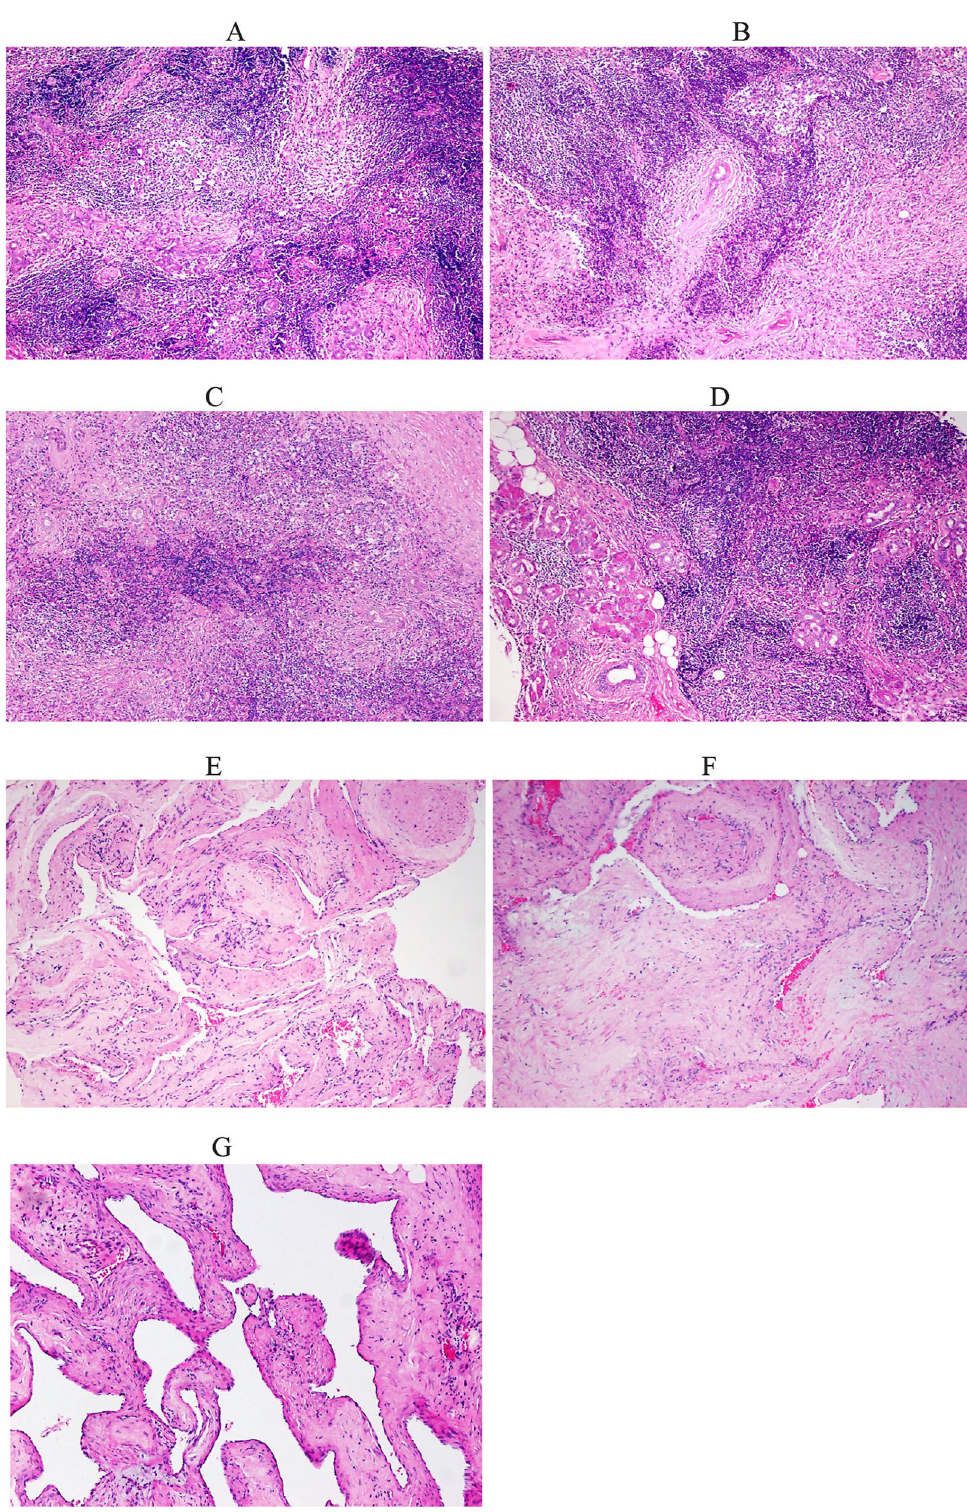
Figure 1. Pathological manifestations of benign lymphoepithelial lesions of lacrimal gland and cavernous hemangioma. ( A – D ) Diffuse infiltration of lymphocytes and plasma cells, atrophy and disappearance of glands, and hyperplasia of fibrous tissue. ( E – G ) The blood filled spaces are relatively uniform in size and are separated by fibrous tissue. (Hematoxylin–Eosin Staining, magnification ×